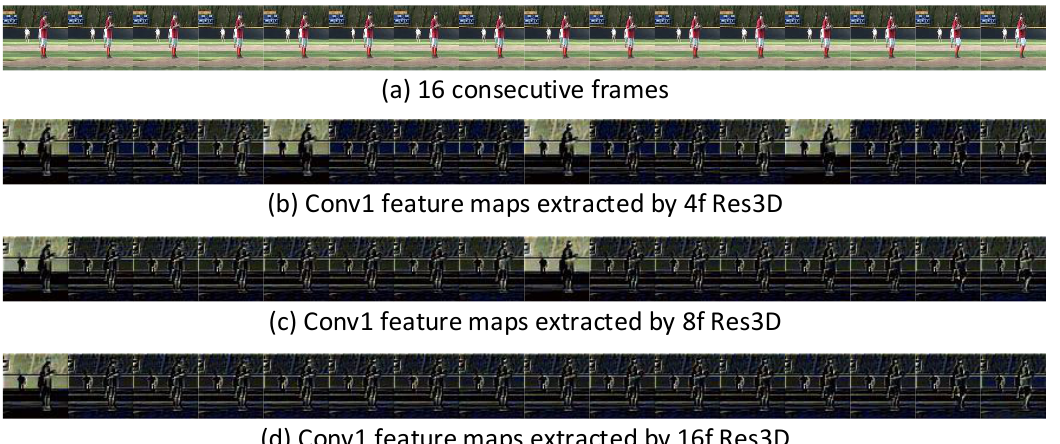
Figure 10. Visualization of the Conv1 feature maps. Res3D captures the appearance information in the first frame of the clip and thereafter captures the motion information.